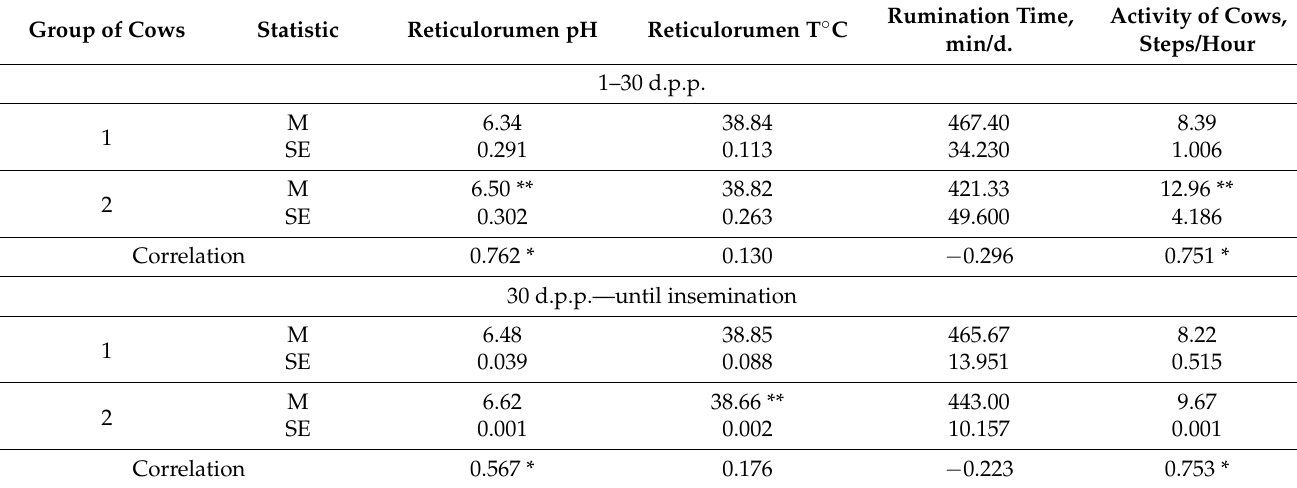
Table 1. Indicators of reticulorumen, rumination time (RT) and activity of cows and their relationship with milk lactose. Group of Cows